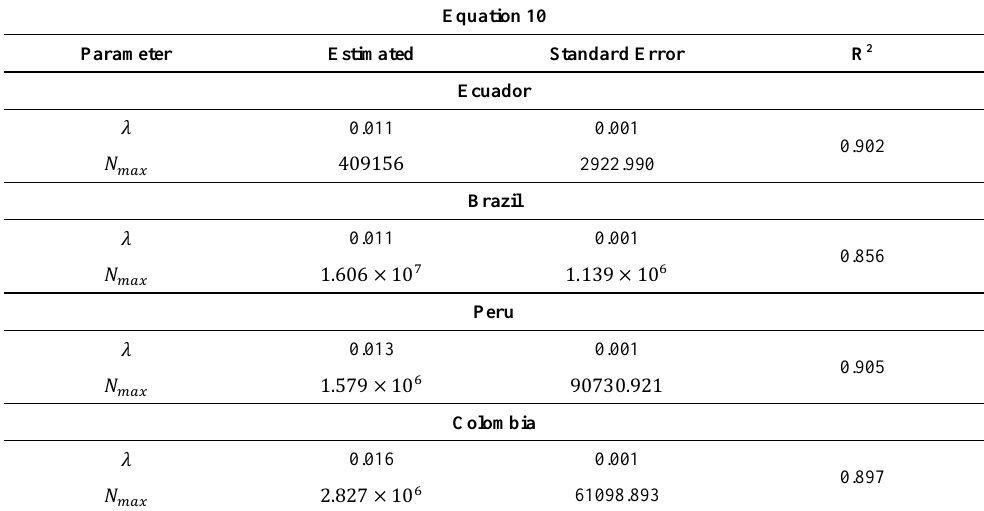
Figure 7. The daily cases as a function of the total confirmed cases. The black markers show the data and the red curve is the regression according to Equation 10. Pink lines represent the confidence level (95%). For comparison, it is analyzed different countries: a) Ecuador, b) Brazil, c) Peru, and d) Colombia. Table 2. Estimated parameters using Equation 10 applied to different countries: Ecuador, Brazil, Peru, and